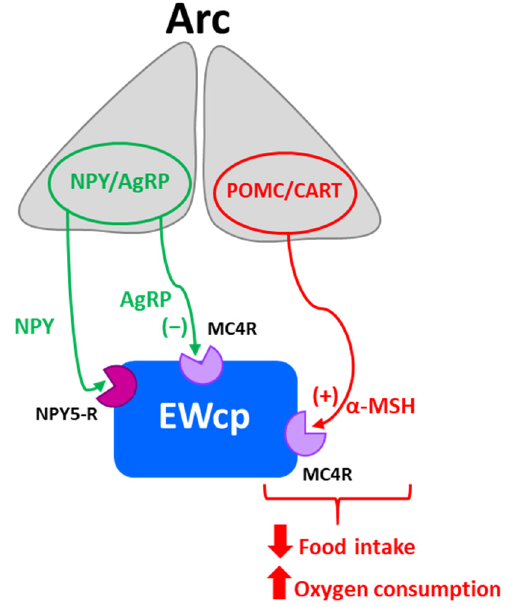
Figure 11. Connections of EWcp with melanocortin pathways from Arc. EWcp receives α -MSH (anorexigenic) and AgRP (orexigenic) projections from Arc and expresses MC4R. Fasting decreases α -MSH signal and increases AgRP signal in EWcp, whereas MC4R blockade in EWcp mimics the effects of fasting. α -MSH injection into EWcp decreased food intake and increased oxygen consumption. These data support the involvement of MC4R signaling in EWcp in the control of food intake and metabolism. For terms, see the list of abbreviations.